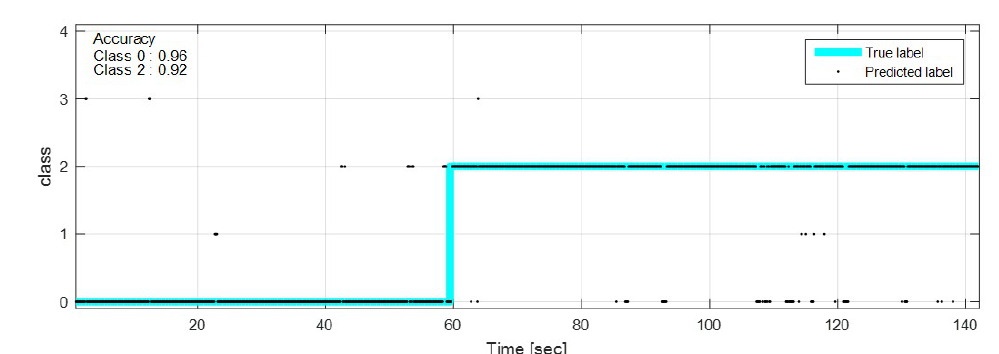
Figure 15. Prediction result on manhole and pothole road, 20 km/h.